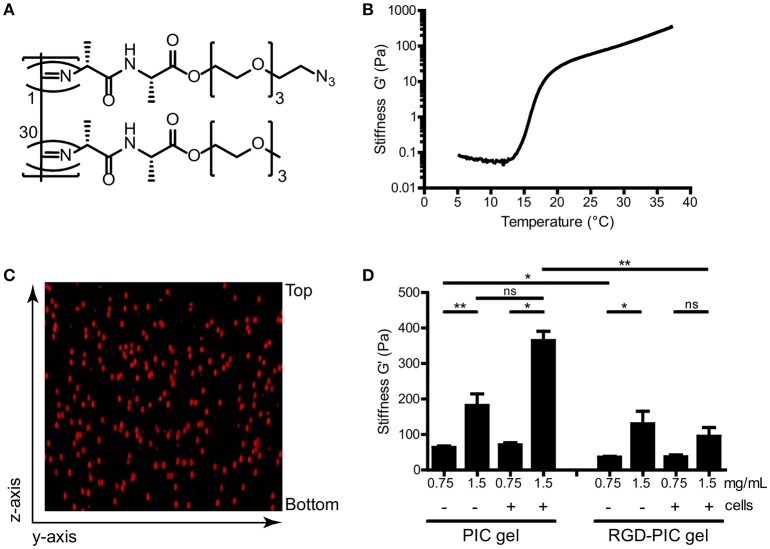
Tri(ethylene glycol)-substituted polyisocyanopeptides (PIC) form soft thermoresponsive gels that can be functionalized via the azide-terminated tail. (A) Molecular structure of polyisocyanopeptides substituted with tri(ethylene glycols) and azide functionalization. Azide-functionalized monomer (top) and unfunctionalized monomer (bottom) are co-polymerized in a 1:30 ratio. (B) Representative rheological analysis of PIC polymers at 1.5 mg/mL without cells, where G′ as a measure of bulk stiffness is set out against temperature. The material gelates at the LCST of 16°C. (C) Z-stack reconstruction of confocal imaging of PKH-26 labeled T cells within PIC hydrogel at 1.5 mg/mL. (D) G′ value as a measure of bulk stiffness of PIC hydrogel and RGD-PIC gels, determined with rheological analysis at 37°C. Between 0.5 × 106 and1 × 106 cells/mL were incorporated into the gels. Values represent mean and standard error of the mean (SEM). Data were analyzed with the Kruskal Wallis test and the Dunns post-test. n = 3–10 in at least three independent experiments. *p ≤ 0.05, **p ≤ 0.01.